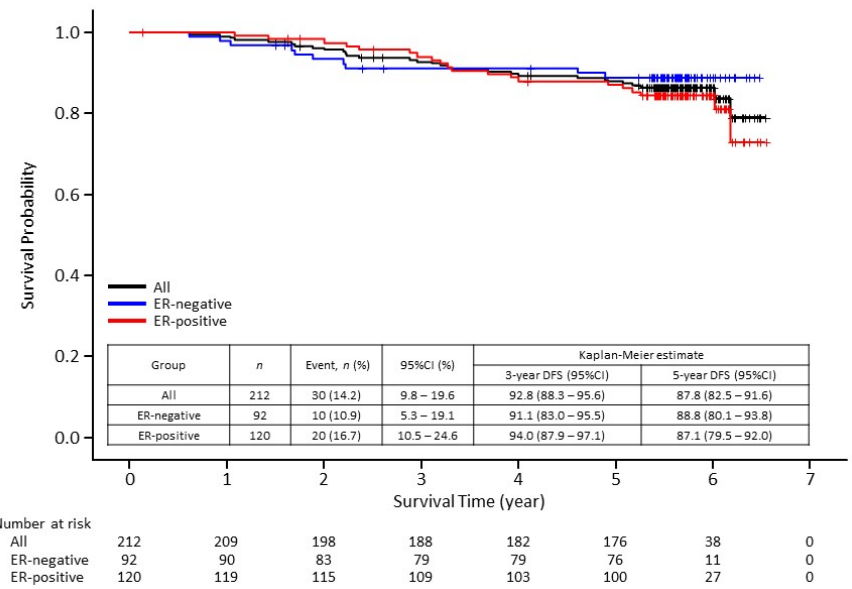
Figure 1. Kaplan–Meier curves of disease-free survival (DFS) in 212 patients enrolled in the Neo-LaTH study comprising 92 estrogen receptor (ER)-negative and 120 ER-positive patients. CI, confidence interval.